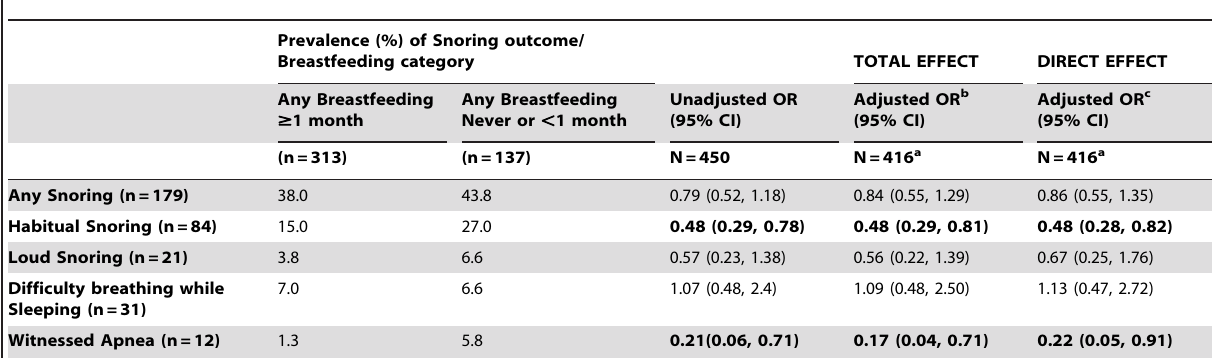
Table 3. Breastfeeding for more than a month and Snoring